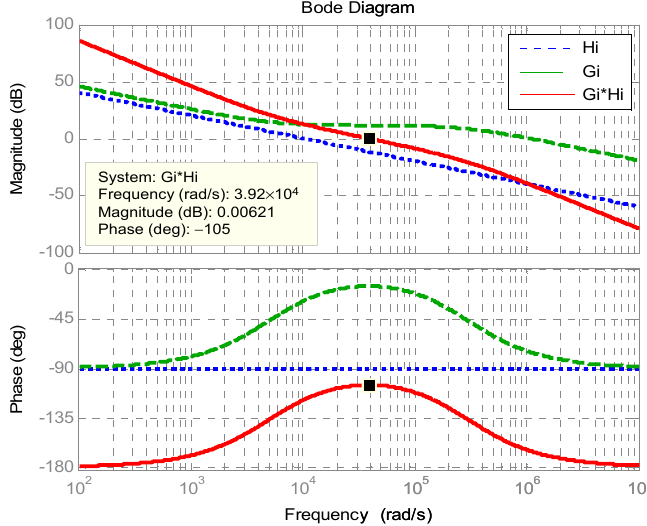
Figure 14. Bode plot of buck-boost converter inductor current control loop.